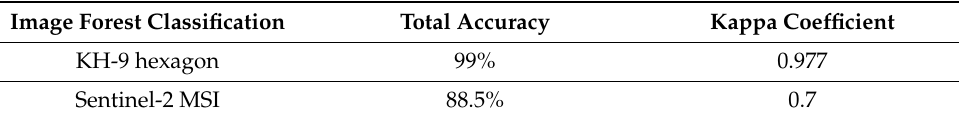
Table 3. Results of validation for the two forest classifications